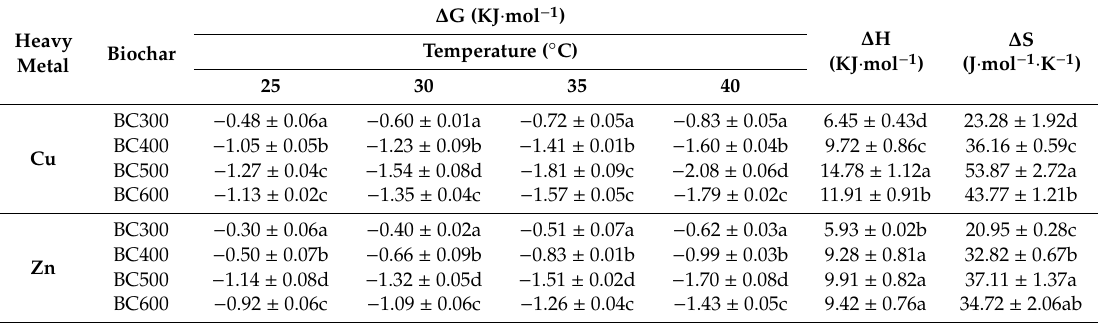
Thermodynamic parameters of Cu and Zn(II) absorption onto BCs produced at di ff erent